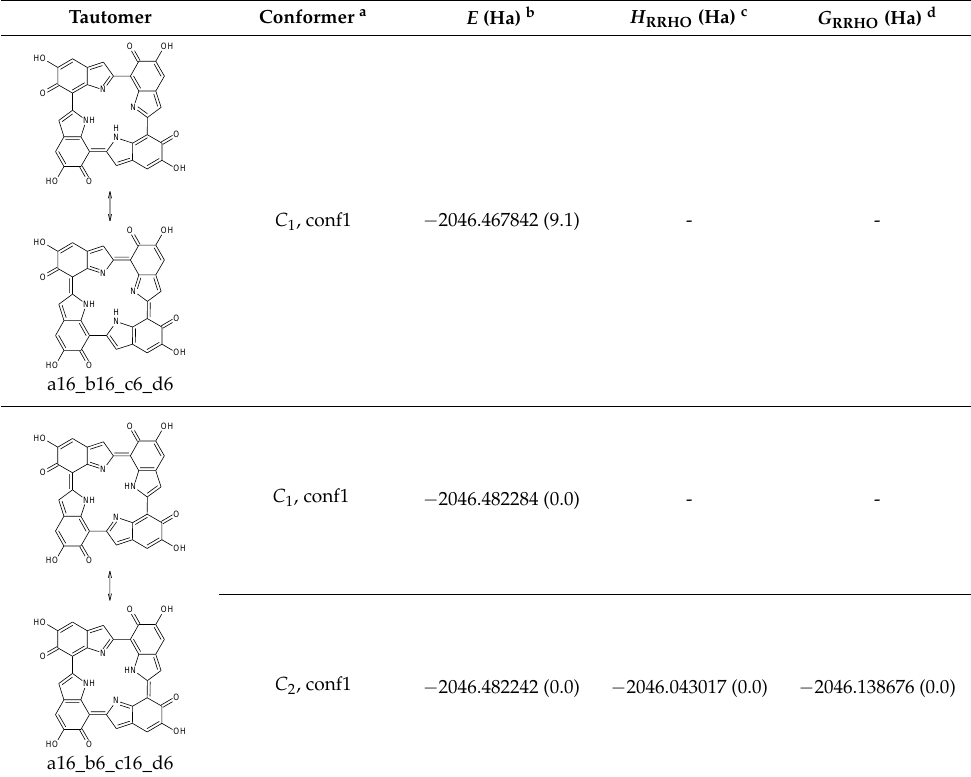
Table 12. KP-6e, neutral form in vacuo.